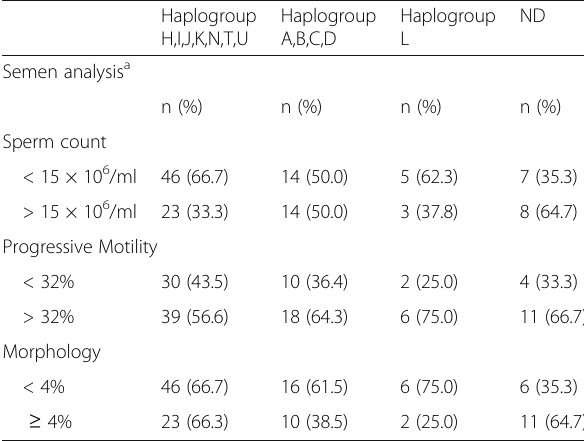
Table 4 Association analysis between mitochondrial haplogroups and sperm characteristics in infertile